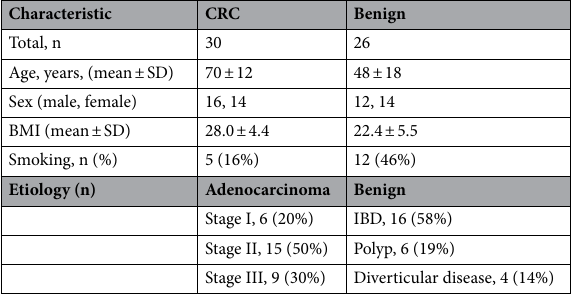
Table 1. Patient characteristics.